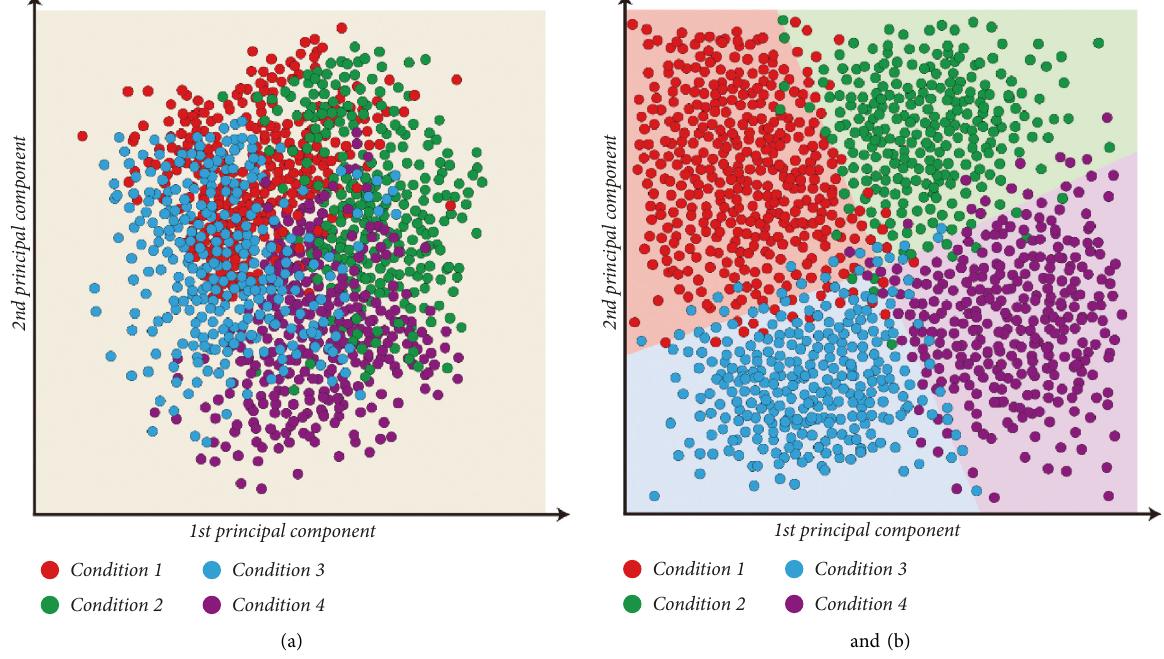
Figure 14: Feature 2-dimensional visualization: (a) raw data and (b) DAE-SVM classification.